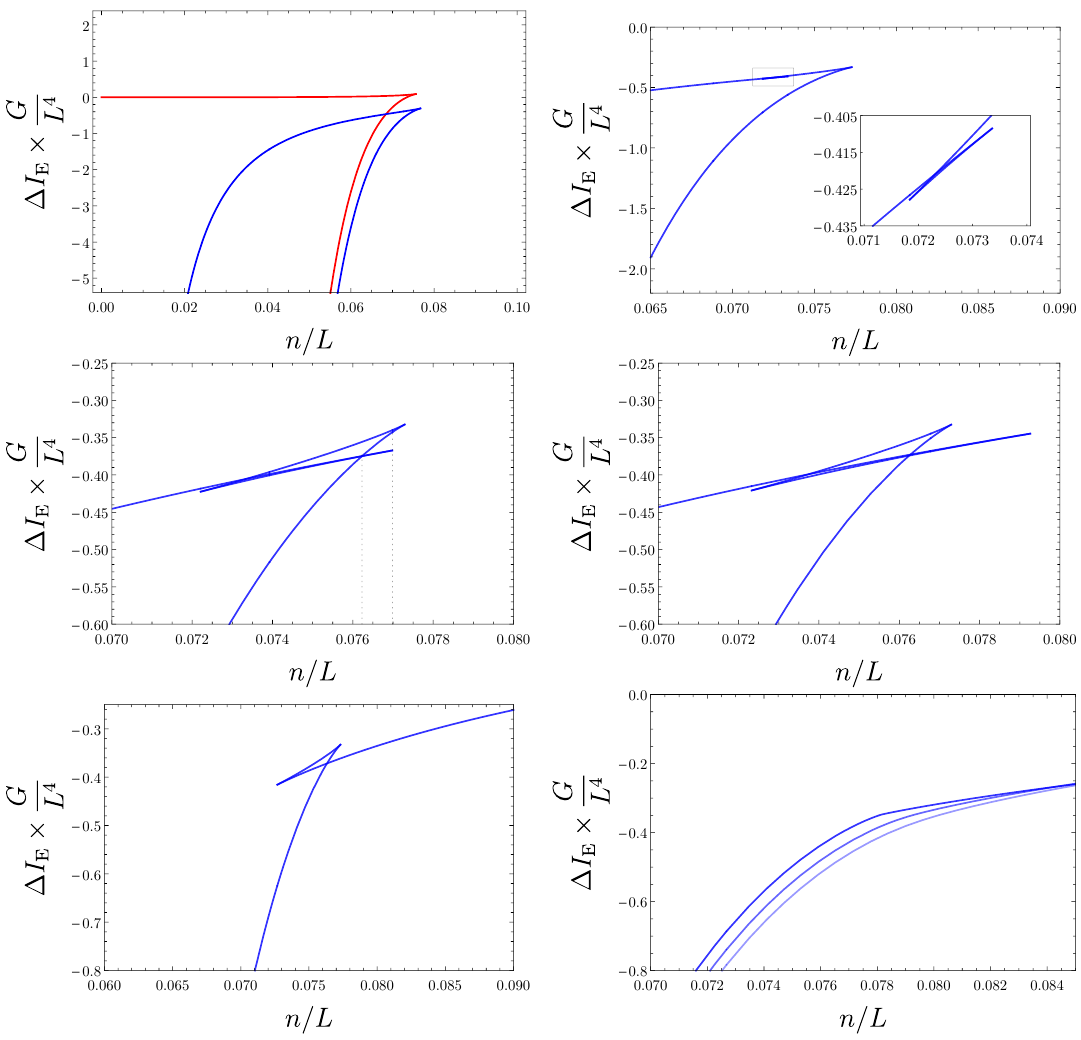
Figure 14 . Euclidean on-shell action di(cid:11)erence (cid:1) I E = I bolt (cid:0) I NUT for B = CP 2 solutions in the E E quartic theories. Red corresponds to Einstein gravity, while all blue curves have (cid:24) = (cid:0) 4 (cid:2) 10 (cid:0) 5 for various values of (cid:16) . Top left: comparing Einstein gravity to the quartic theories with (cid:16) = (cid:0) 10 (cid:2) 10 (cid:0) 5 , we see in both cases the action is a ‘cusp’. Top right: here (cid:16) = (cid:0) 23 : 5 (cid:2) 10 (cid:0) 5 ; the inset shows a zoomed-in plot of the boxed area, showing the swallowtail structure that has emerged. Center left: here (cid:16) = (cid:0) 23 : 74 (cid:2) 10 (cid:0) 5 ; the swallowtail now intersects the lower branch of the cusp. The vertical dotted lines correspond to a (cid:12)rst order phase transition (leftmost line) and a zeroth-order phase transition (rightmost line). Center right: here (cid:16) = (cid:0) 23 : 82 (cid:2) 10 (cid:0) 5 . The swallowtail has elongated, and now extends past the cusp. Bottom left: here (cid:16) = (cid:0) 24 : 1 (cid:2) 10 (cid:0) 5 . Bolts now exist for all values of n , and there is a swallowtail structure present. Bottom right: here (cid:16) = (cid:0) 38 : 026 (cid:2) 10 (cid:0) 5 ; (cid:0) 50 (cid:2) 10 (cid:0) 5 and (cid:0) 60 (cid:2) 10 (cid:0) 5 (more to less opacity, respectively). Along the (cid:12)rst curve, there is a critical point located at n=L (cid:25) 0 : 07815, while the other two curves are smooth. The structure of the on-shell action is qualitatively similar to these last two curves for all (cid:16) . (cid:0) 38 : 026 (cid:2) 10 (cid:0) 5